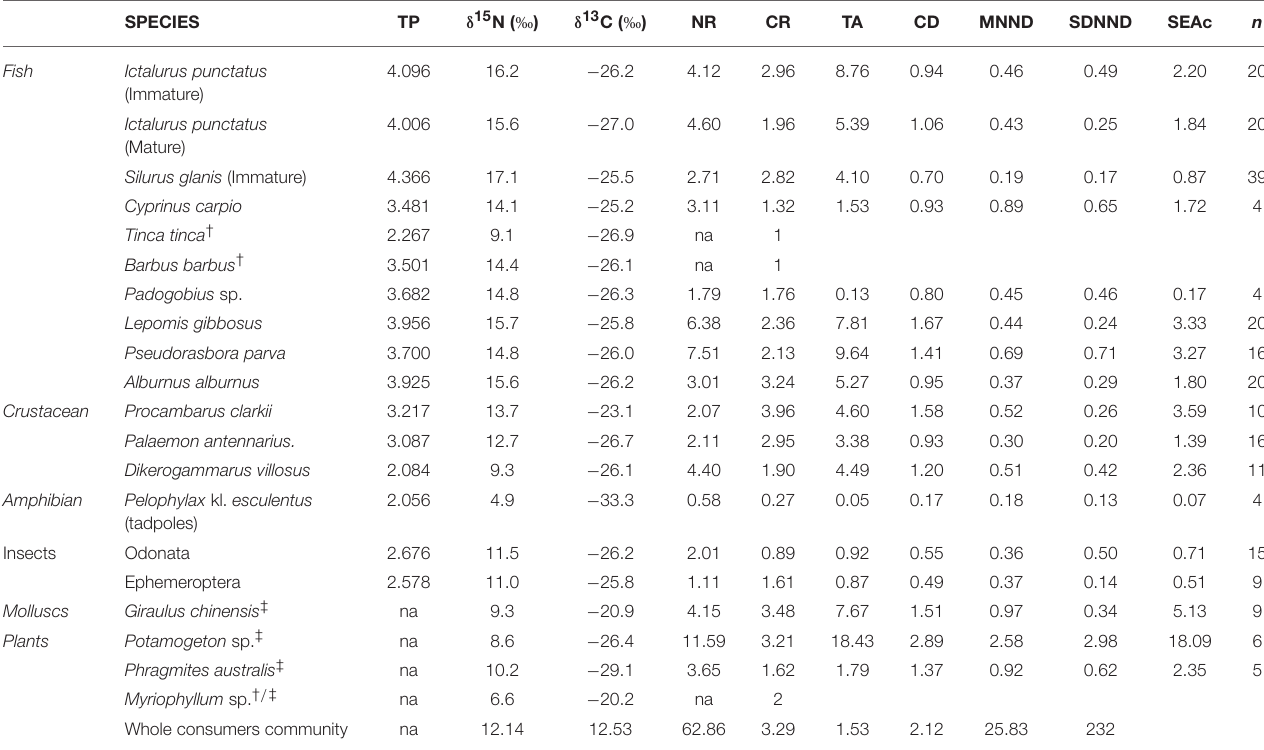
TABLE 3 | Mean values of isotopic signatures, estimated trophic positions, Layman’s metrics. SPECIES